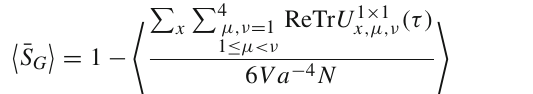
Table 3 The matching prefactors between the smoothing schemes of the Wilson flow with time τ , cooling at level n c , APE smearing with level n APE andfinallystoutsmearingwithlevel n st .Theleftmostcolumn corresponds to the left hand side of the matching equation while the uppermost row to the scale of the right hand side i.e. n APE (cid:19) 2 α